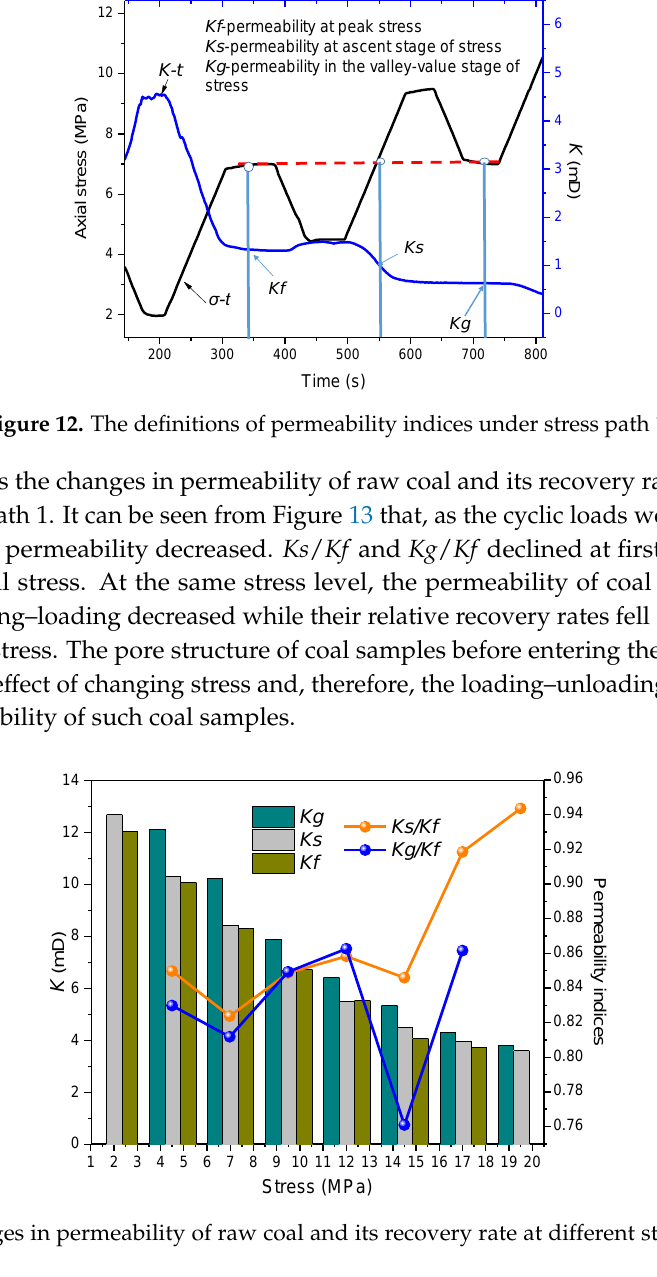
Figure 11. The axial stress–axial strain and permeability–axial strain curves of raw coal during each cycle under stress path 3. ( a ) The first cycle. ( b ) The second cycle. ( c ) The third cycle. ( d ) The fourth cycle. ( e ) The fifth cycle. ( f ) The sixth cycle. ( g ) The seventh cycle.